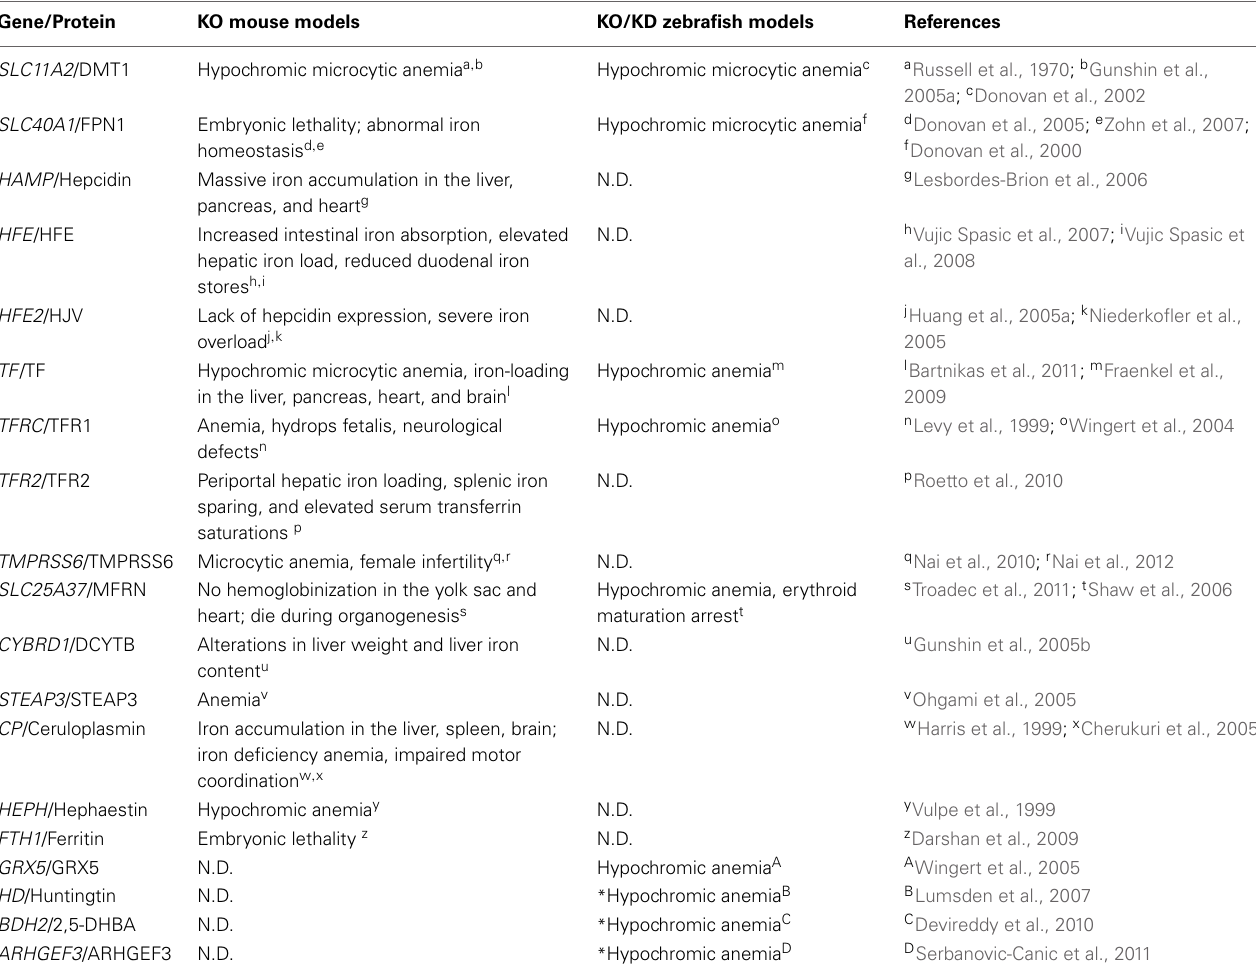
Table 2 | Iron metabolism–related mouse and zebrafish knockout/knockdown models and their phenotypes.